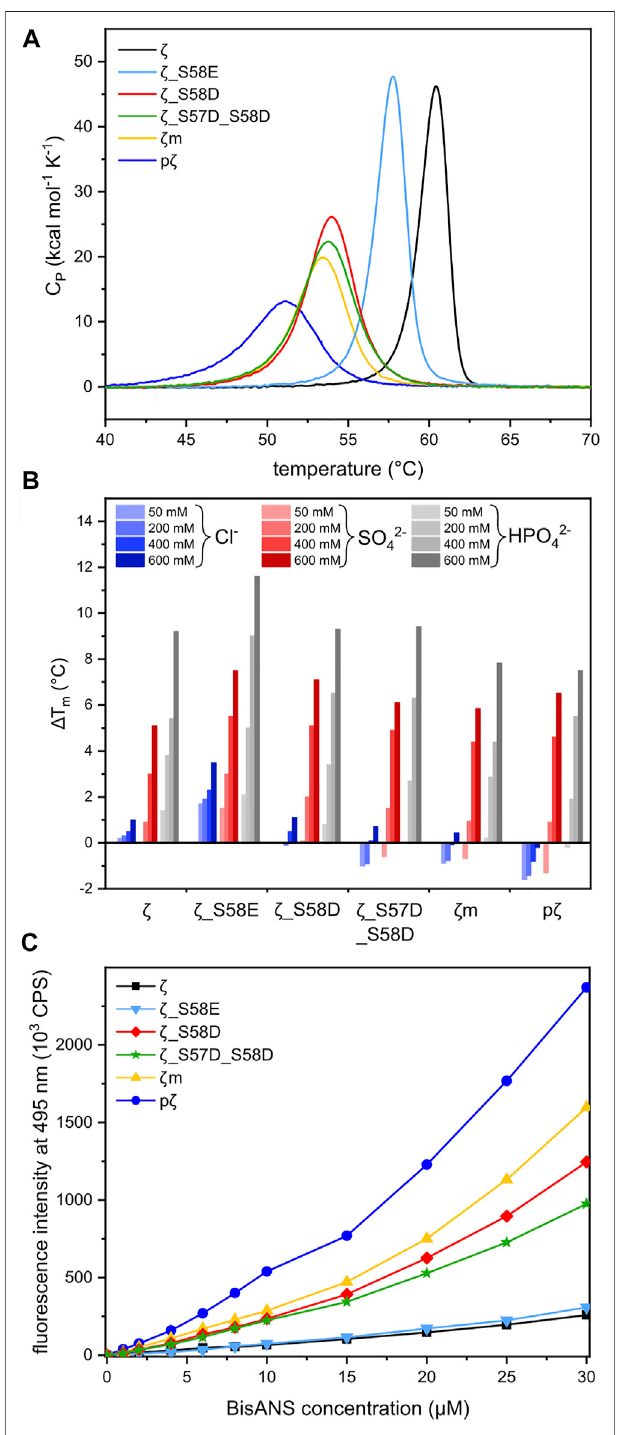
FIGURE 5 | Thermal stability and hydrophobicity of 14-3-3 ζ variants. (A) DSC thermograms of 14-3-3 ζ proteins demonstrating differences in T m and global unfolding. T m values were determined from the peak maxima. (B) Diverse effects of selected sodium salts on the stability of 14-3-3 ζ variants. T m of each protein variant in 20 mM HEPES pH 8 (Supplementary Table S1) was set as a reference (0 ° C). (C) BisANS fl uorescence intensity at 495 nm used for comparison of 14-3-3 ζ